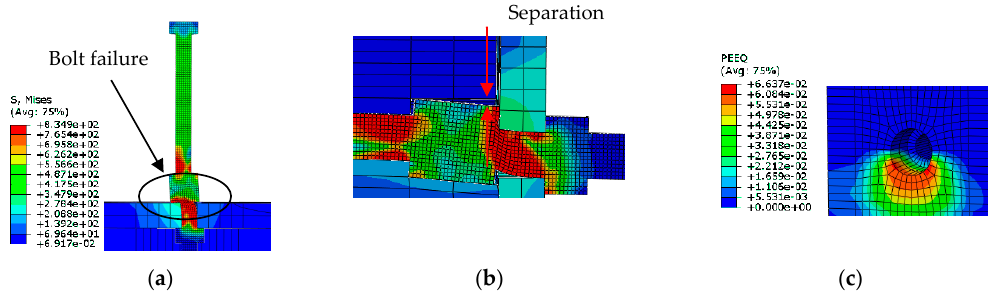
Figure 10. Finite element failure mode of 16 mm high-strength bolt shear connector (Units: MPa): ( a ) bolt failure; ( b ) separation between the concrete and bolt; ( c ) concrete exfoliation.